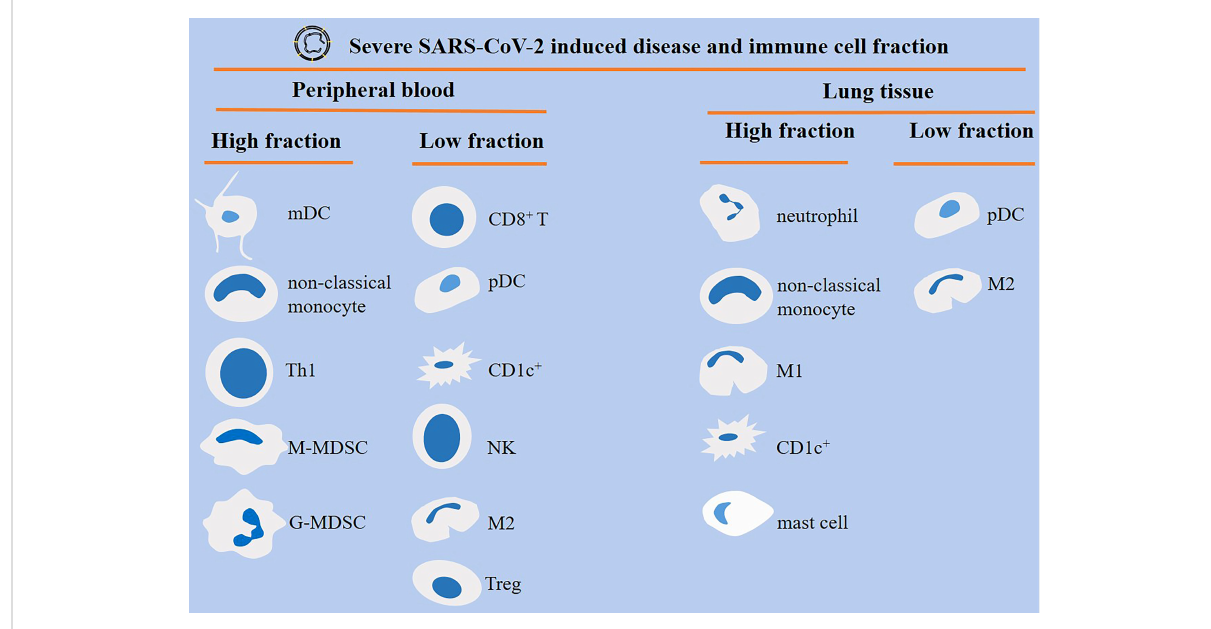
FIGURE 4 Different orchestration of cells of the immune system within the blood or lung of patients with severe SARS-CoV-2-induced disease. Monocyte- derived DCs (mDCs), non-classical monocytes, T helper 1 (Th1) cells, and myeloid-derived suppressor cells (MDSCs) are high in the peripheral blood of patients with severe disease. By contrast, CD8 + T cells, plasmacytoid DCs (pDCs), CD1c + DCs, natural killer (NK) cells, macrophage type 2 (M2) cells, and regulatory T cells (Tregs) show low fraction within the circulation. M1 macrophages are high, whereas M2 macrophages are low within the lung of severe